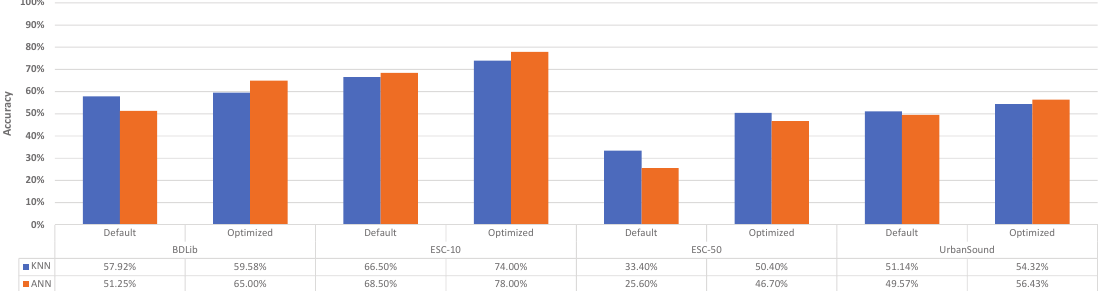
Figure 6. Achieved accuracy of the classifiers with their default and optimized configuration.